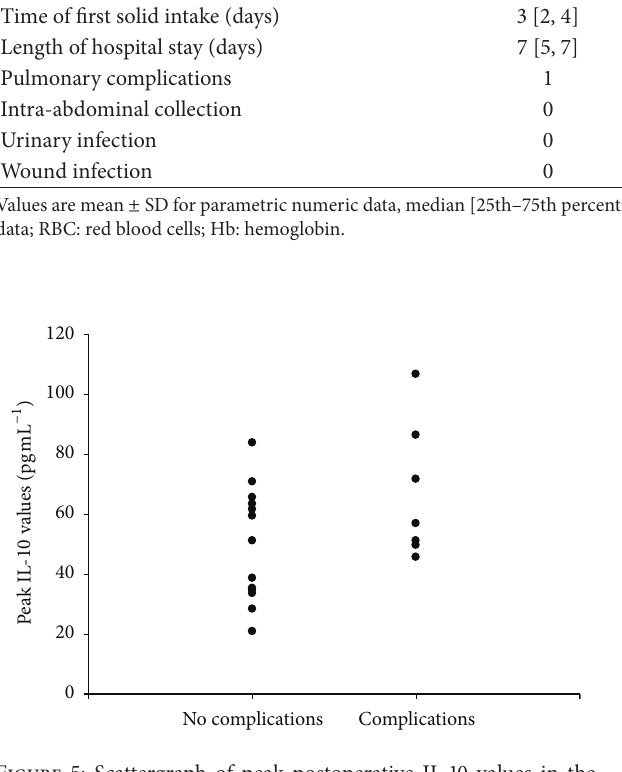
Figure 5: Scattergraph of peak postoperative IL-10 values in the seven patients who developed postoperative complications and in the 13 patients who did not. A trend for higher peak IL-10 values in the patients with complications was demonstrated ( 𝑃 = 0.09